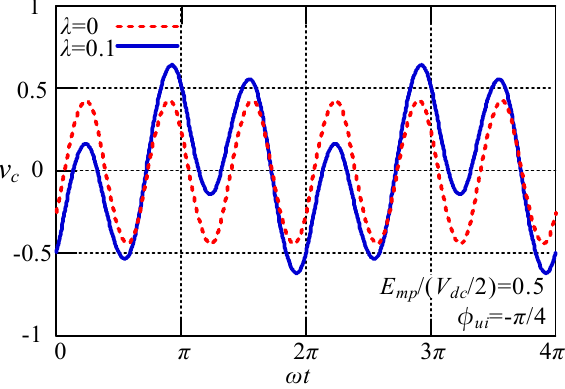
Figure 3. The waveforms of v c under different grid conditions.